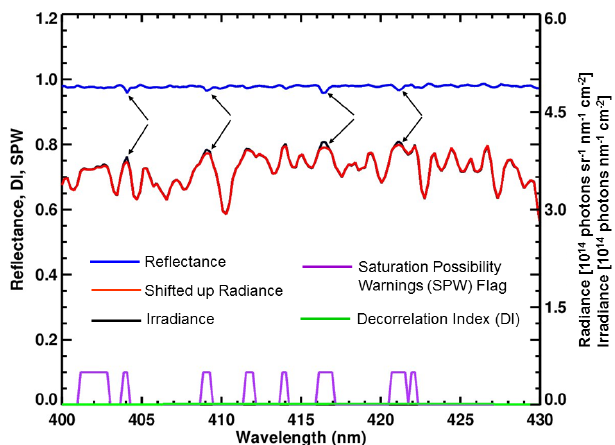
Figure 2. Data for iTimes 839, row 15, orbit 7990, 14 January 2006 in zone A (this pixel is marked by arrows in Fig. 1c, d). The blue line at the top of the picture is reflectance πI/ [ F 0 cos (θ) ] , where θ is so- lar zenith angle. Reflectance in this zone has slight variations caused by minor saturation in the atmospheric spectrum, as indicated by the arrows. The purple line shows the binary SPW flags multiplied by 0.1. The green line is the DI < 0.01 for bands 403–413, 413–424 and 424–434nm. The intensity of the radiance spectrum is shifted upwards slightly for clearer comparison with the irradiance spec- trum.